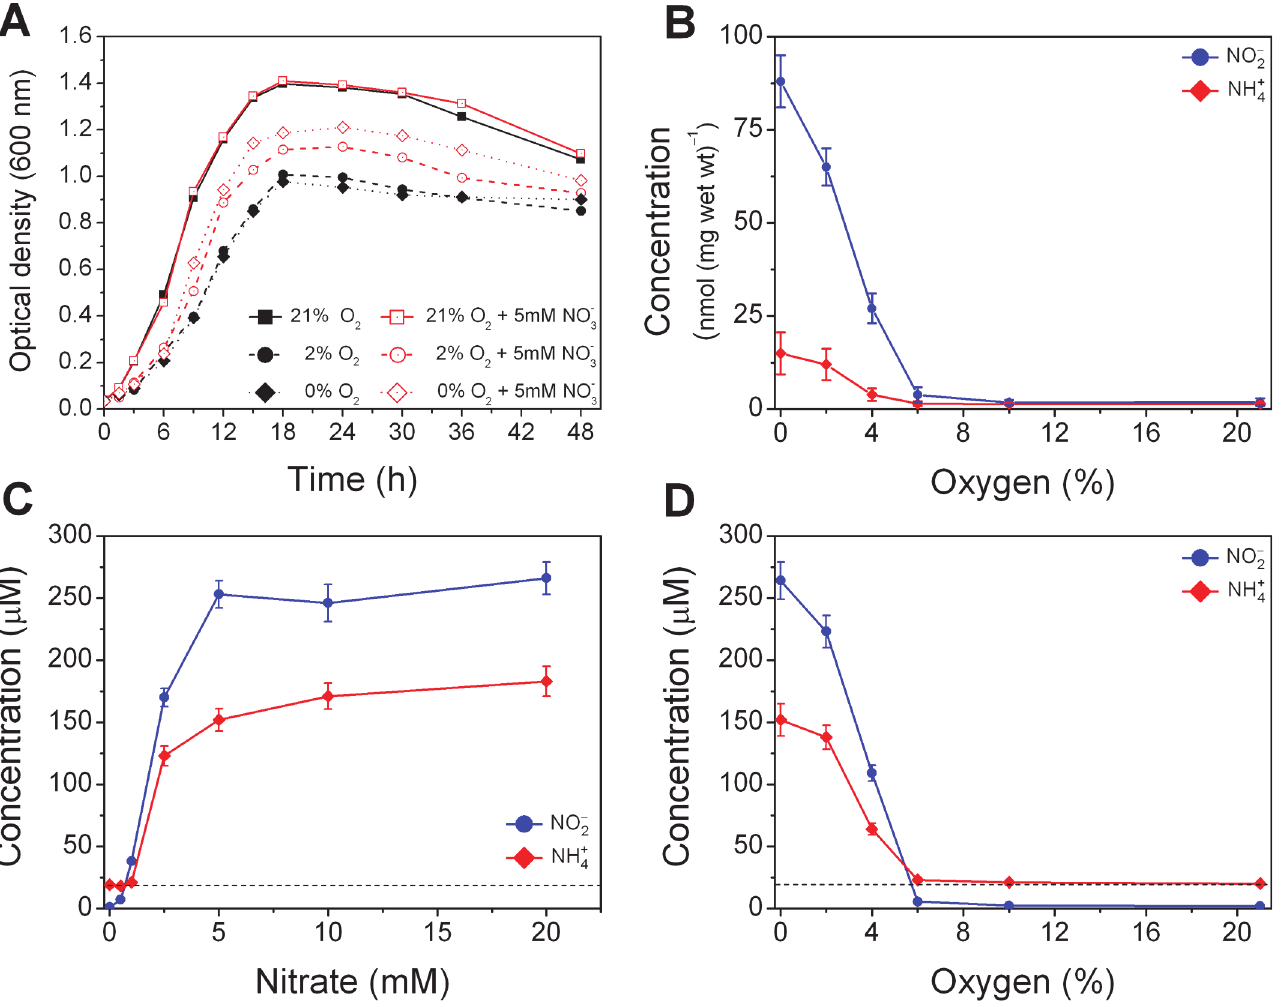
Fig 1. Nitrate and oxygen effect on E.coli bacterial cultures growth and formation of nitrite and ammonia. (A) Growth curves for E.coli MG1655 grown in the absence (black closed symbols) or in the presence of 5 mM nitrate (red open symbols) at 37°C in LMRS broth at 21%, 2%, and 0% O 2 concentrations (respectively square, circle and diamond symbols). (B) Concentration of nitrite and ammonia (blue and red solid lines) in E.coli pellets after 24 h growth at different oxygen levels with 5 mM nitrate. (C) and (D) Respectively dependence on nitrate (at 0% O 2 ) and oxygen (at 5 mM nitrate) of nitrite and ammonia concentrations in the cell-free culture media after 24h growth. The ammonia content of LMRS alone is indicated by the dashed lines. Values are means ± SD (n = 3). The average SD resulted smaller than the symbols dimensions (0.04 OD) and it is not shown for